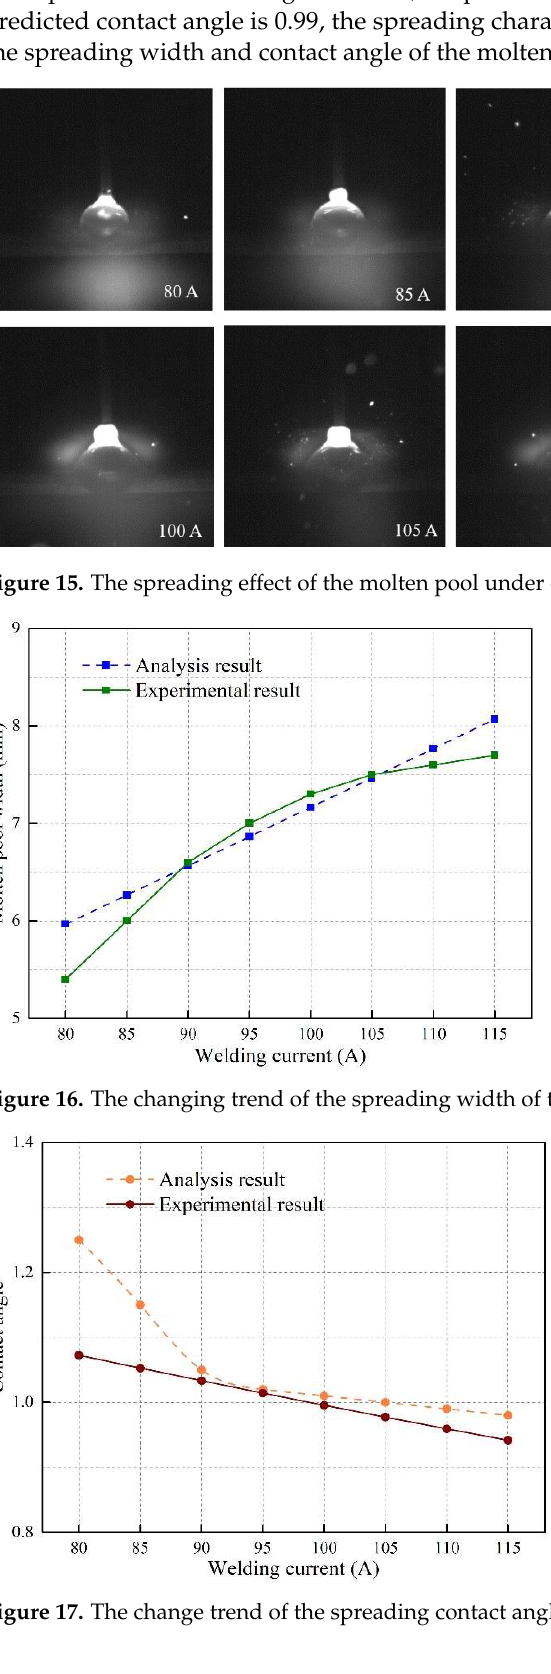
Figure 17. The change trend of the spreading contact angle of the molten pool. 5. Conclusions In this study, based on the controlled cycle of cold metal transition, a theoretical model of the controlled driving and spreading of the cold metal transition bath was estab- lished, and the mechanism of the single controlled driving and spreading of the molten bath was deduced. The arc pressure, droplet impact and residual energy on the surface of the molten pool have a decisive influence on the flow process of the molten pool. The sum of the forces on the surface of the molten pool can determine the surface shape of the keyhole and change the overall size of the molten pool. The welding current has a decisive effect on the flow behavior of the molten pool. Increasing the welding current cannot change the remaining height of the molten pool, but it can increase the width of the molten pool and reduce the contact angle of the molten pool. The welding current is increased from 80 A to 100 A, the maximum melting width is increased from 6.15 mm to 7.65 mm, and the maximum contact angle is reduced from 1.65 to 1.56.